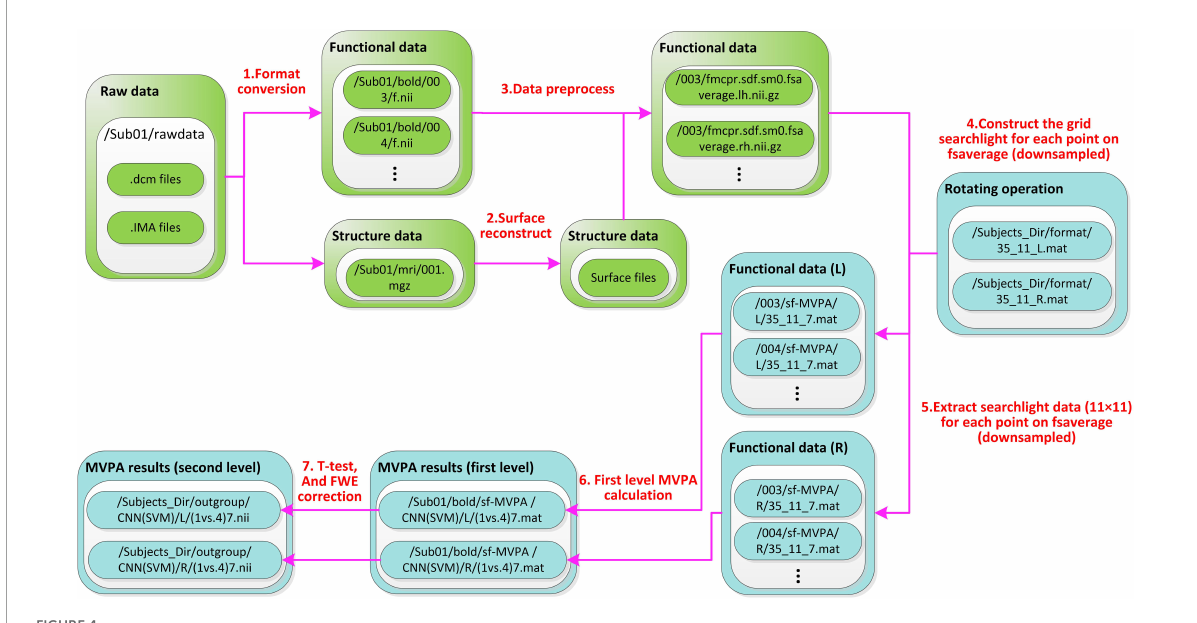
FIGURE4 File stream of SF-MVPA. The preprocess module is green and the SF-MVPA module is cyan. Raw fMRI data (.dcm, IMA files, etc.) are stored in Sub0X/rawdata. After format conversion, structure data are stored in/Sub0X/mri/001.mgz and functional data are stored in/Sub0X/bold/00X/f.nii. Surface reconstruction produces a lot of files, which are stored in the folder/Sub0X/mri. After data preprocessing, functional data are stored in/Sub0X/bold/00X/fmcpr.sdf.sm0.fsaverage.l(r)h.nii.gz. The string “fmcpr.sdf.sm0.fsaverage.l(r)h.nii.gz” has meanings: “mc” means motion correction, “pr” means per-run, “sdf” means that the preprocessing process includes slice timing correction, “sm0” means do not perform spatial smoothing, “fsaverage” means that the data uses the template of fsaverage. The rotating operation produces two files (i.e., 35_11_L.mat and 35_11_R.mat), which are stored in the folder/Subjects_Dir/format. Both files contain a 16,002 × 124 cell array. Each row of the cell array corresponds to a point in the downsampled fsaverage template. The first column contains the spherical coordinates ( α , β ). The 2 ∼ 122 columns (11 × 11 = 121 cells) contain the vertices (of the undownsampled fsaverage template) covered by each cell. The 123th column contains the vertices (of the undownsampled fsaverage template) covered by the current point. The 124th column contains the adjacent